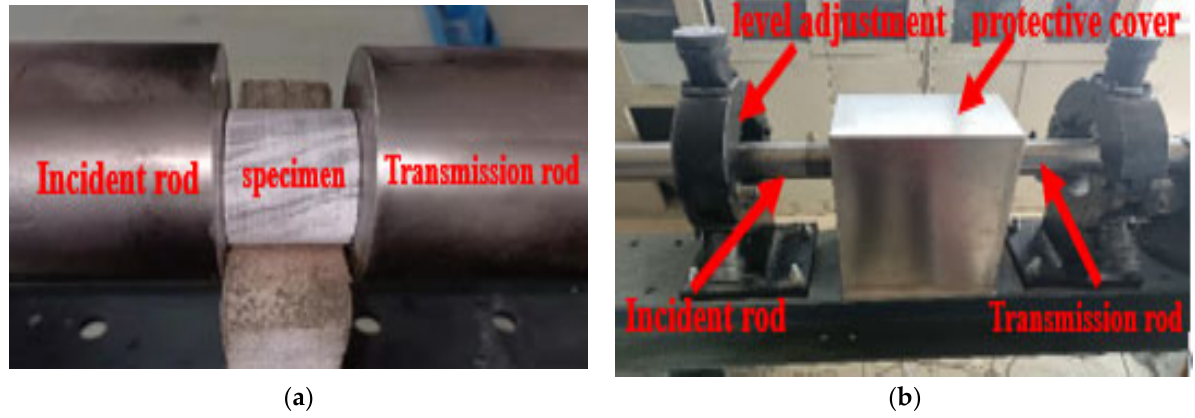
Figure 5. Schematic diagram of specimen loading. ( a ) Schematic diagram of loading; ( b ) Schematic diagram of loading device.